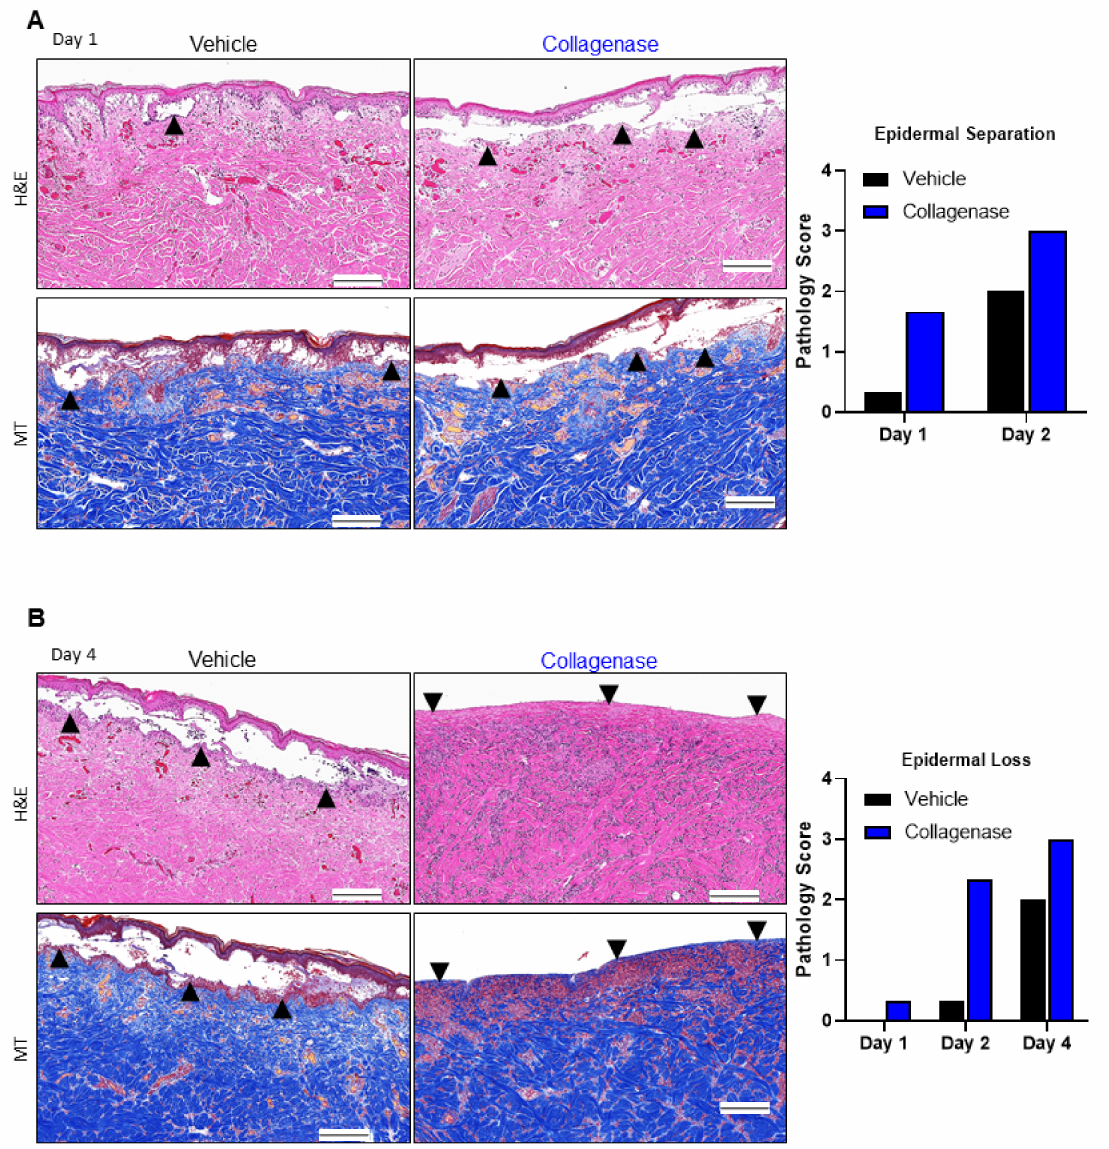
Figure 2. Collagenase-treated burns show early epidermal separation and epidermal loss. Histological analyses of burn comb interstices in pigs via hematoxylin–eosin (H&E) and Masson’s trichrome (MT) stains. ( A ) H&E and MT stains showed early epidermal separation relative to vehicle-treated wounds, indicated by black arrows. ( B ) H&E and MT stains showed early epidermal loss relative to vehicle-treated wounds, indicated by black arrows. For the histopathology grading system, see Table 1. Black scale bars represent 200 µ m. Pathology scores for 4 biopsies per time point and per treatment ( n = 4) were averaged and the columns represent the average